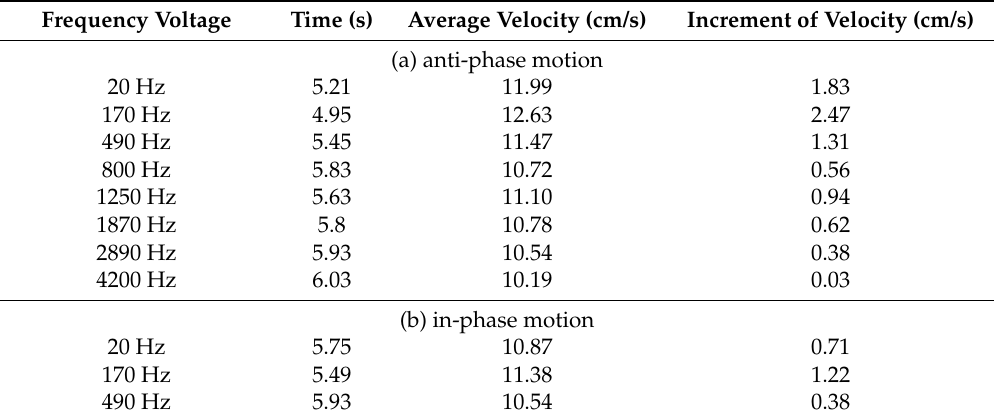
Table 7. The average flow velocity and gain of the pumping